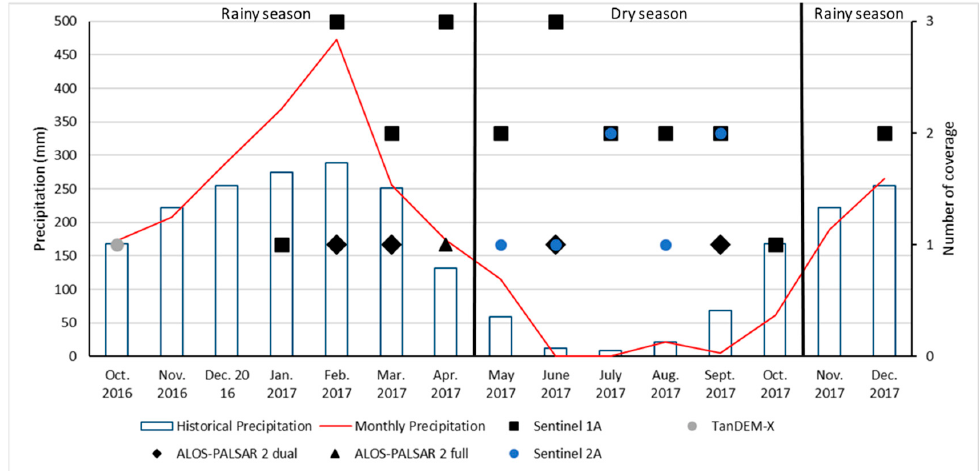
Figure 3. . Historical (1961–2017) and Monthly (2016–2017) precipitation values and acquisition dates of Sentinel 2A, ALOS PALSAR 2 full, ALOS PALSAR 2 dual, TanDEM-X and Sentinel 1A. Precipitation data were collected from the Diamatino fluviometric station located near to the study area.